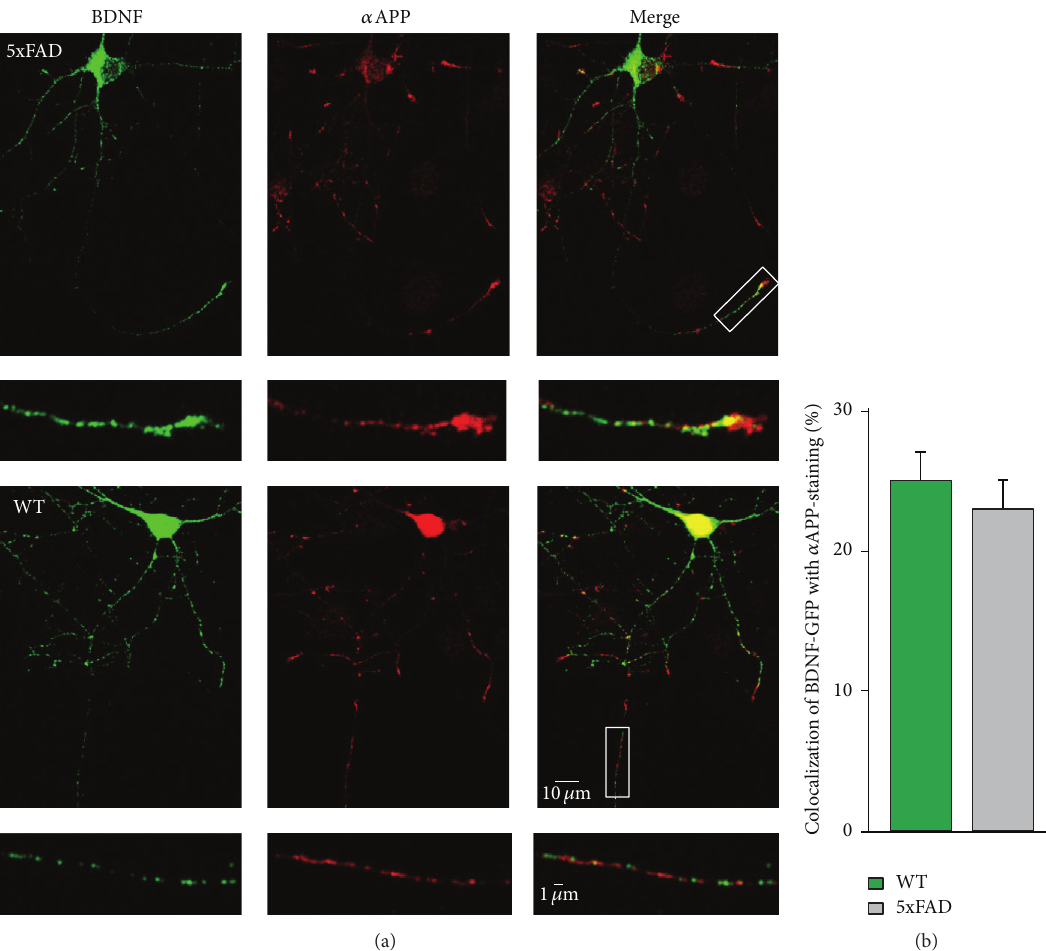
Figure 3: A subpopulation of BDNF-containing vesicles colocalize with APP. (a) Dissociated hippocampal cultures of 5xFAD mice and wild-type littermates were transfected with BDNF-GFP (green) and immunostained with an antibody directed against the N-terminus of endogenous APP (red). Representative pictures showing a transfected and immunostained hippocampal WT neuron (upper part) and 5xFAD neuron (lower part) and higher magnification of boxed areas. Mature BDNF colocalized with APP in vesicular structures. (b) Percentage of 𝛼 APP staining colocalizing with total BDNF-GFP area. Error bars represent